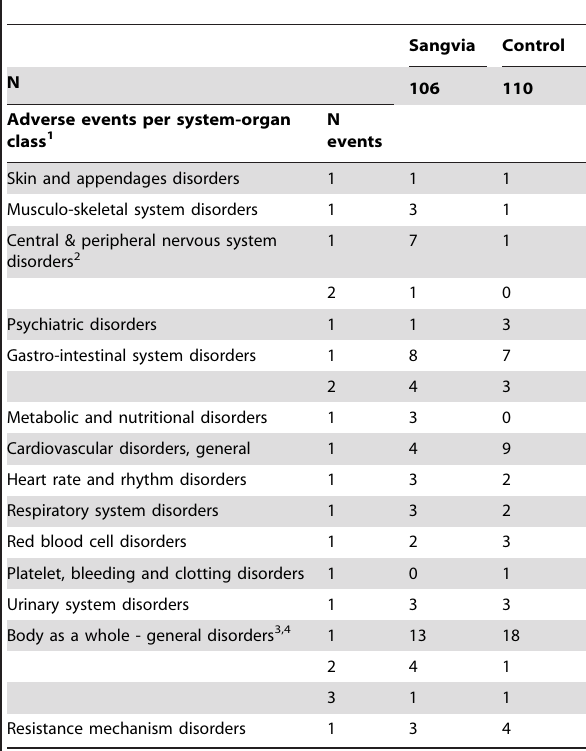
Table 4. All (serious) adverse events coded according to